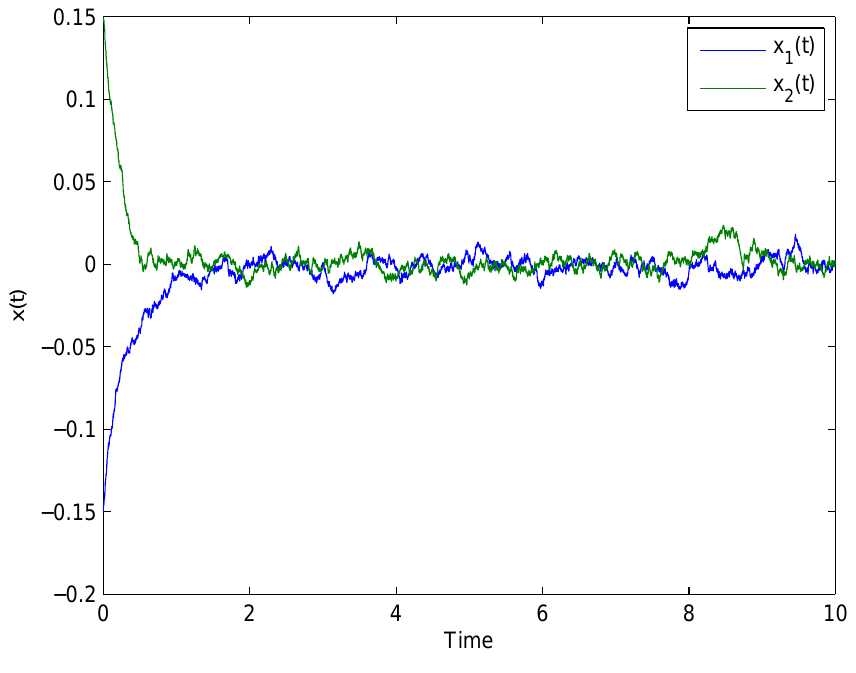
Figure 4. Response solution of the system